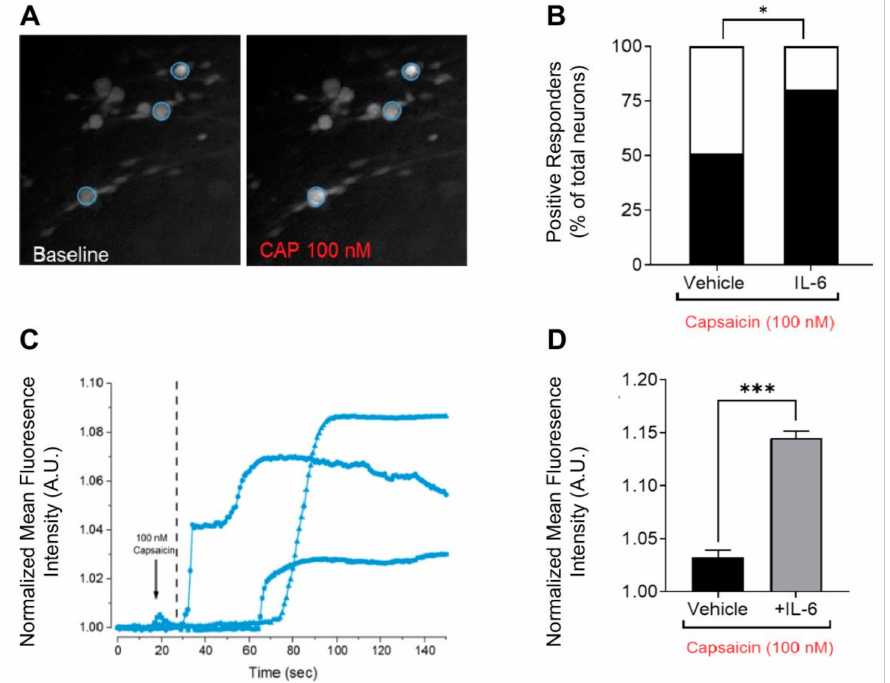
Figure 3. Local treatment of the axonal microenvironment with inflammatory cytokine IL-6 enhances capsaicin-evoked responsiveness. ( A ) Representative soma images in short-term experiments of